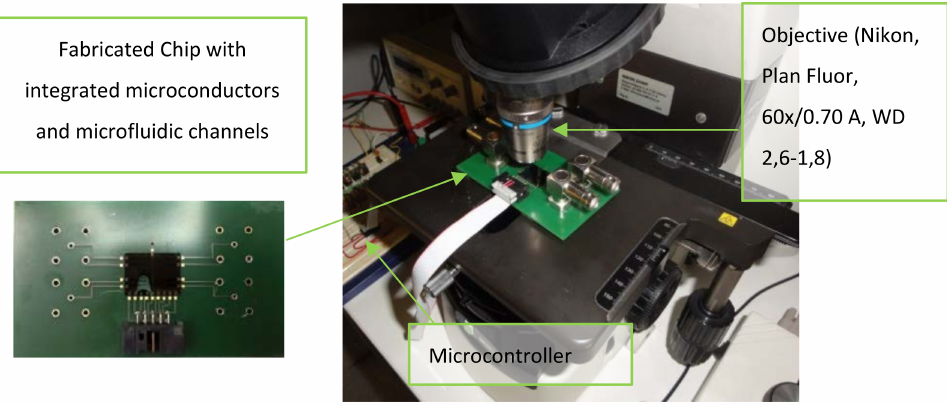
Figure 7. The microfluidic platform placed underneath the fluorescence microscope stage under 60 × magnification, Plan Fluor objective with 2.6–1.8 mm working distance. After the measurement set with varying known E. coli concentrations was conducted, the new chip was sealed to the same PCB (printed circuit board) and measurements were repeated. WD: working